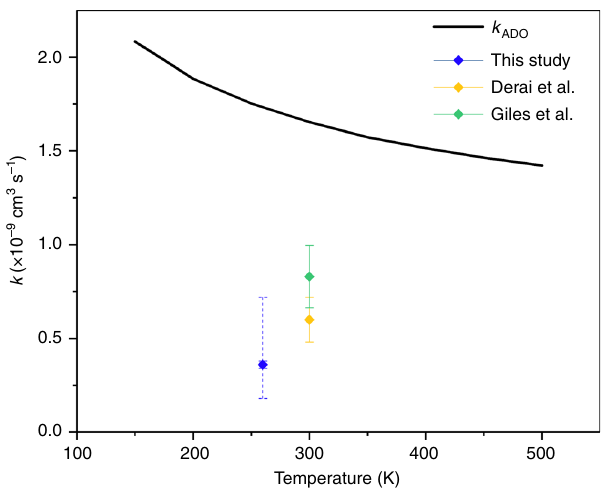
Fig. 3 Comparison between Xe þ + NH 3 charge exchange rate constants. Reaction rate constants obtained from the ADO model (black line) and from several experimental measurements are plotted for the Xe þ þ NH 3 reaction. The result from Derai et al. 29 is provided in yellow, Giles et al. 30 is in green (both at 300 K) and our result (at 260 K) is plotted in blue. All of the experimental reaction rate constants are lower than the ADO model prediction. Note that a second (dashed) error bar is included in the rate constant established in this work. The additional error bar is to allow for the factor of two uncertainty in the partial pressure readings (as these were taken using a pressure gauge) for comparison with the previous